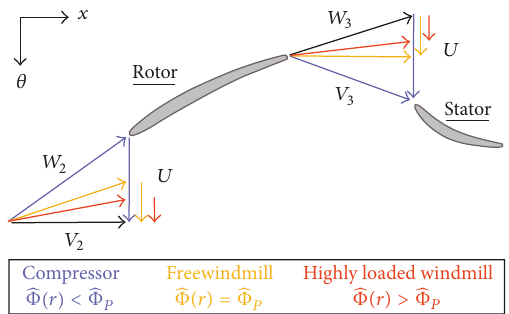
Figure 1: Velocity diagrams from compressor to load-controlled windmill.